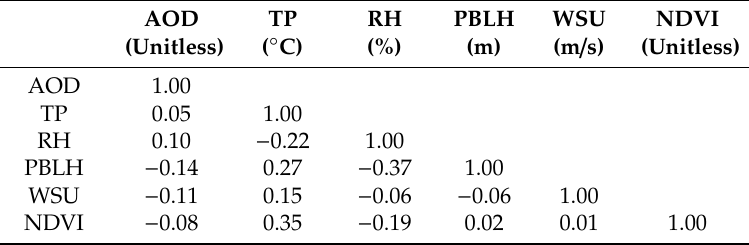
Table 1. Correlation coe ffi cients (R 2 ) between each of the independent variables used for building the models. AOD TP RH PBLH WSU NDVI (Unitless) ( ◦ C) (%) (m) (m / s) (Unitless) AOD 1.00 TP 0.05 1.00 RH 0.10 − 0.22 1.00 PBLH − 0.14 0.27 − 0.37 1.00 WSU − 0.11 0.15 − 0.06 − 0.06 1.00 NDVI − 0.08 0.35 − 0.19 0.02 0.01